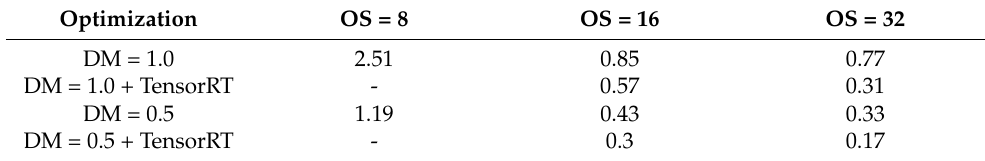
Table 9. Inference time performance